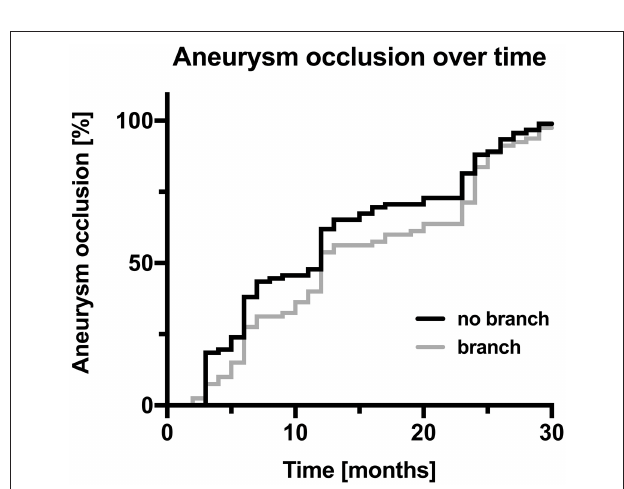
FIGURE 2 | Kaplan–Meier curves of the percentage of aneurysm occlusion over time; cases comprising a branch originating from the aneurysm covered by the flow diverter are displayed in gray, and cases without a branch originating from the aneurysm are displayed in black.